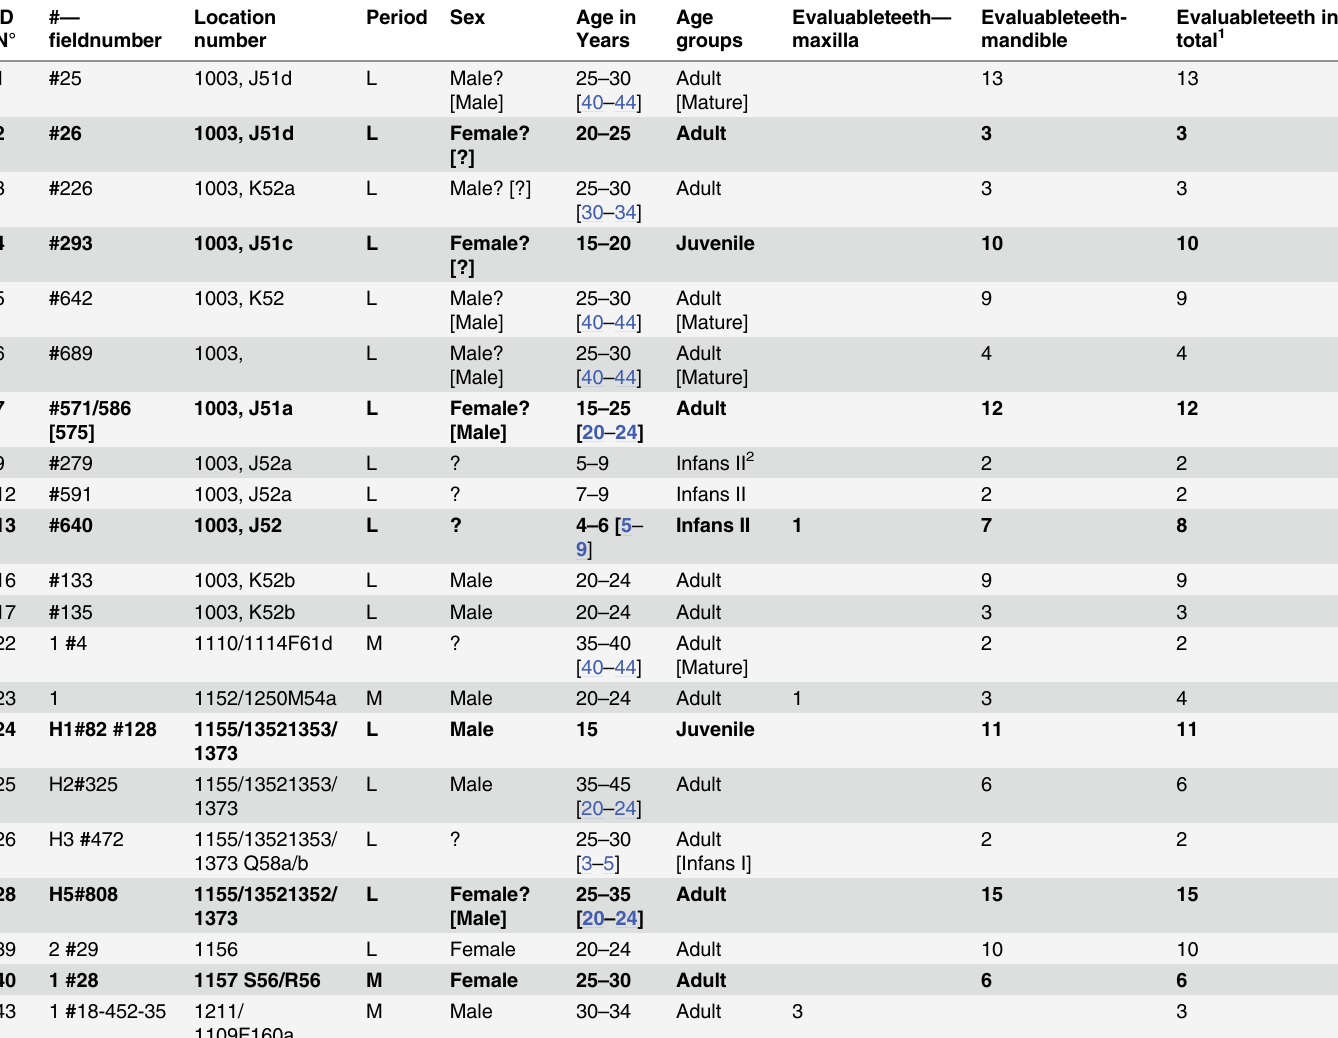
Table 1. Archaeological and relevant anthropological data of the analyzed individuals from Kfar